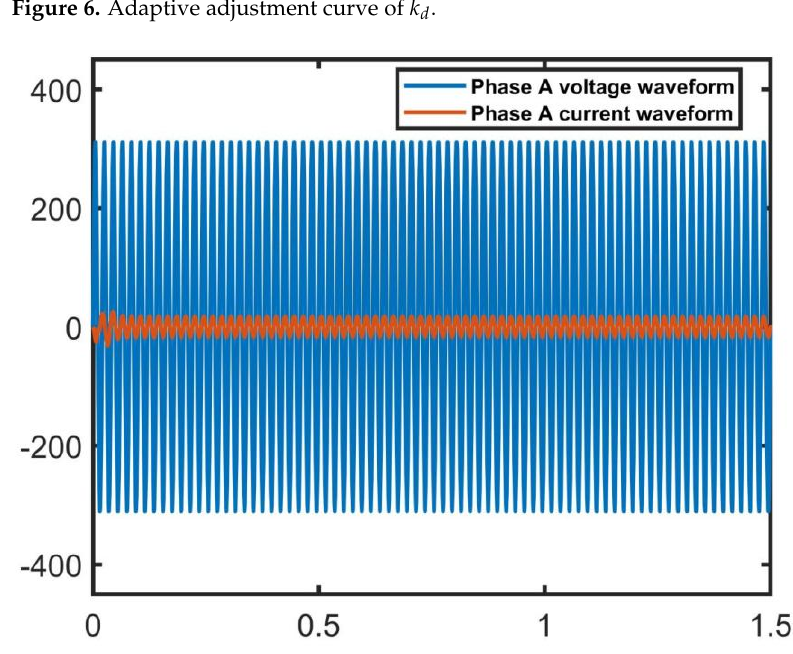
Figure 7. Phase A voltage and current waveform.